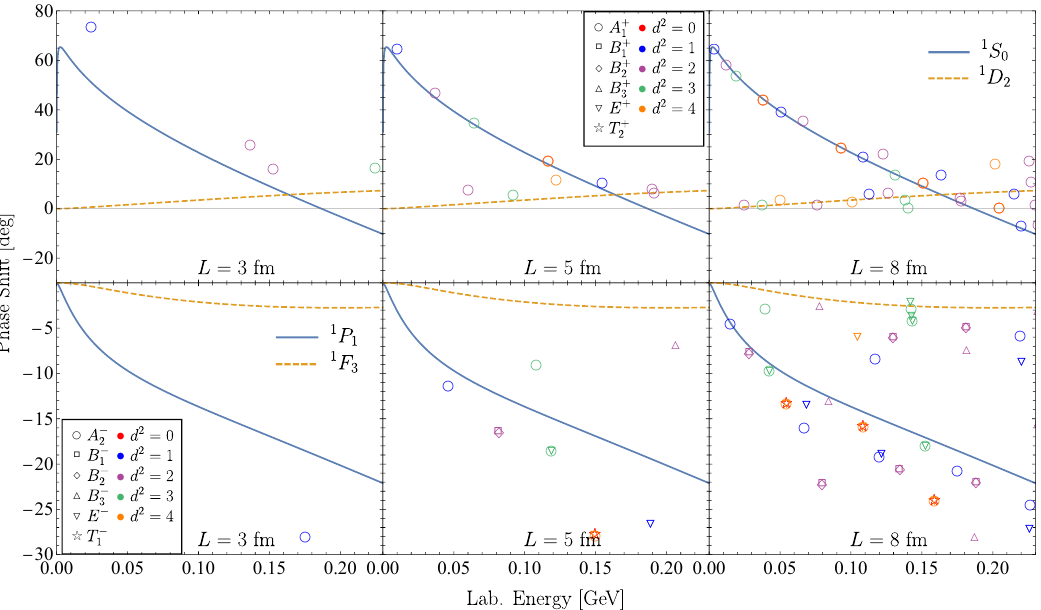
Figure 4 . Upper (lower) row: various symbols show positive-parity (negative-parity) phase shifts calculated from the FV energy spectra using the S-wave (P-wave) Lüscher formula for the chiral EFT potential at NNLO. Solid and dashed lines in the upper row (lower row) show the 1 S 0 and 1 D 2 ( 1 P 1 and 1 F 3 ) phase shifts, respectively, calculated in the infinite volume. For remaining notations see figure